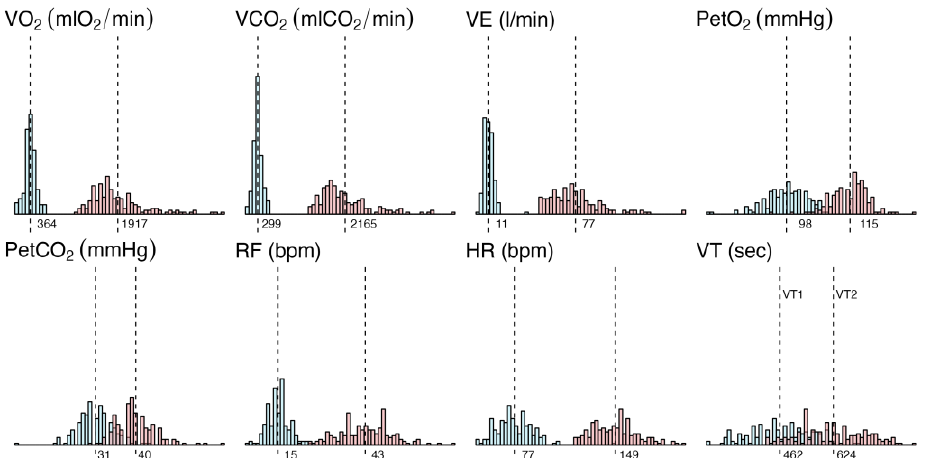
Figure 4. Distribution of the minimum and maximum values (and their corresponding average) of the main variables across the entire Oxynet dataset: O 2 uptake (VO 2 ) in mlO 2 /min, exhaled CO 2 (VCO 2 ) in mlCO 2 /min, ventilation (VE) in l/min, end-tidal O 2 (PetO 2 ) and CO 2 (PetCO 2 ) in mmHg, respiratory frequency (RF) in bpm, heart rate (HR) in bpm and exercise thresholds (VT1 and VT2) in seconds from the beginning of the exercise.